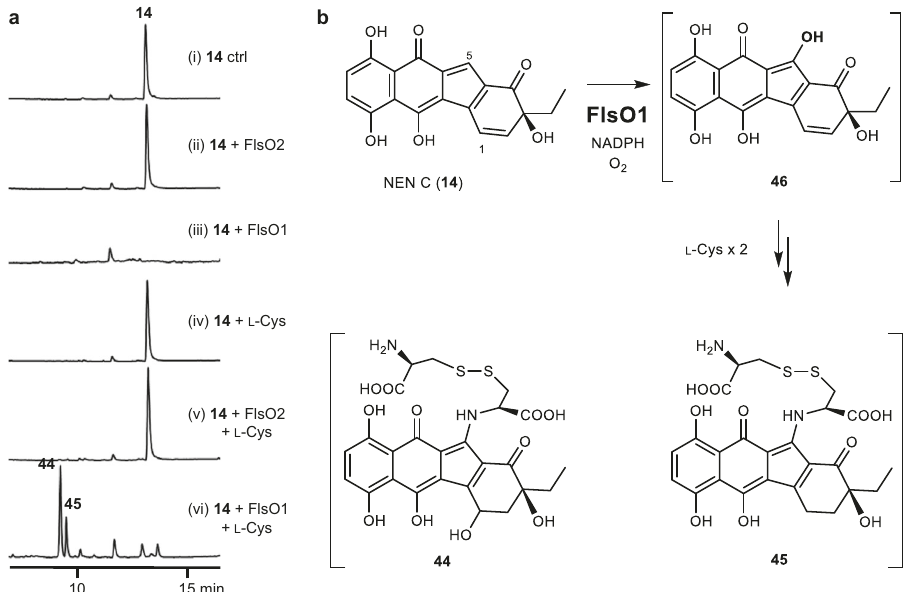
Fig. 4 | In vitro Characterization of the physiological function of FlsO1 using NEN C ( 14 ) as a substrate mimic. a HPLC analysis of enzyme assays. The assays wereperformedbyincubationof200 μ M 14 ,2mMNADPH,intheabsenceof L -Cys, with(i)control(noenzyme);(ii)10 μ MFlsO2;(iii)10 μ MFlsO1;orinthepresenceof